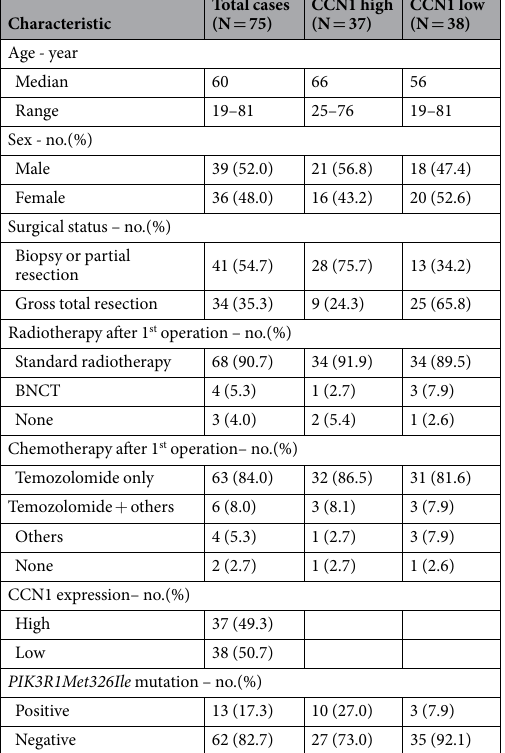
Table 2. Clinical and genetic characteristics of the glioblastoma study cohort. SRS = stereotactic radiosurgery; BNCT = boron neutron capture